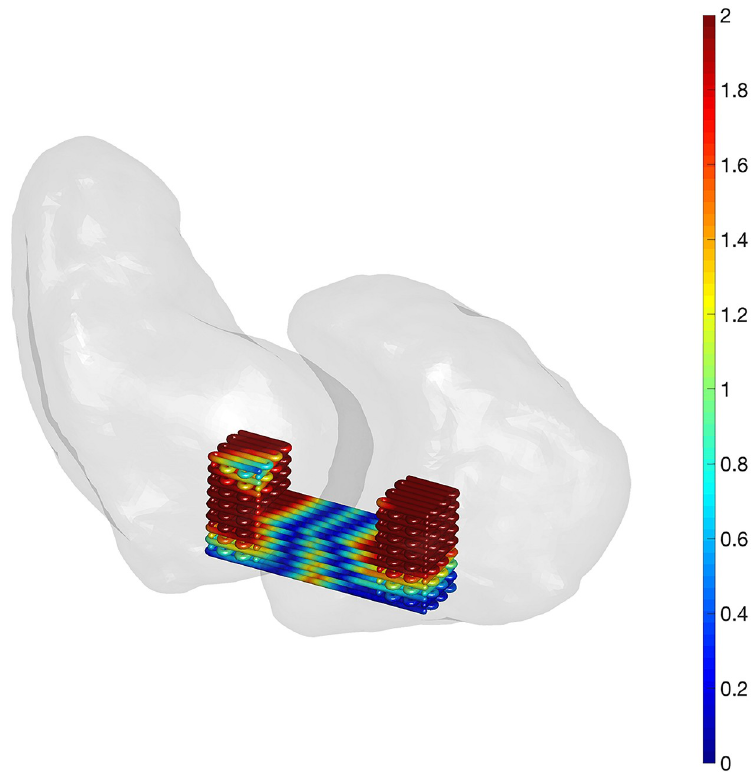
Fig 16. Closest point distance (mm) from an optimised scaffold to scaphoid and lunate. The length of the ligament-scaffold is 7 mm. The scaffold is placed at the proximal site according to Fig 5d. The scale bar is in the range from 0 to 2